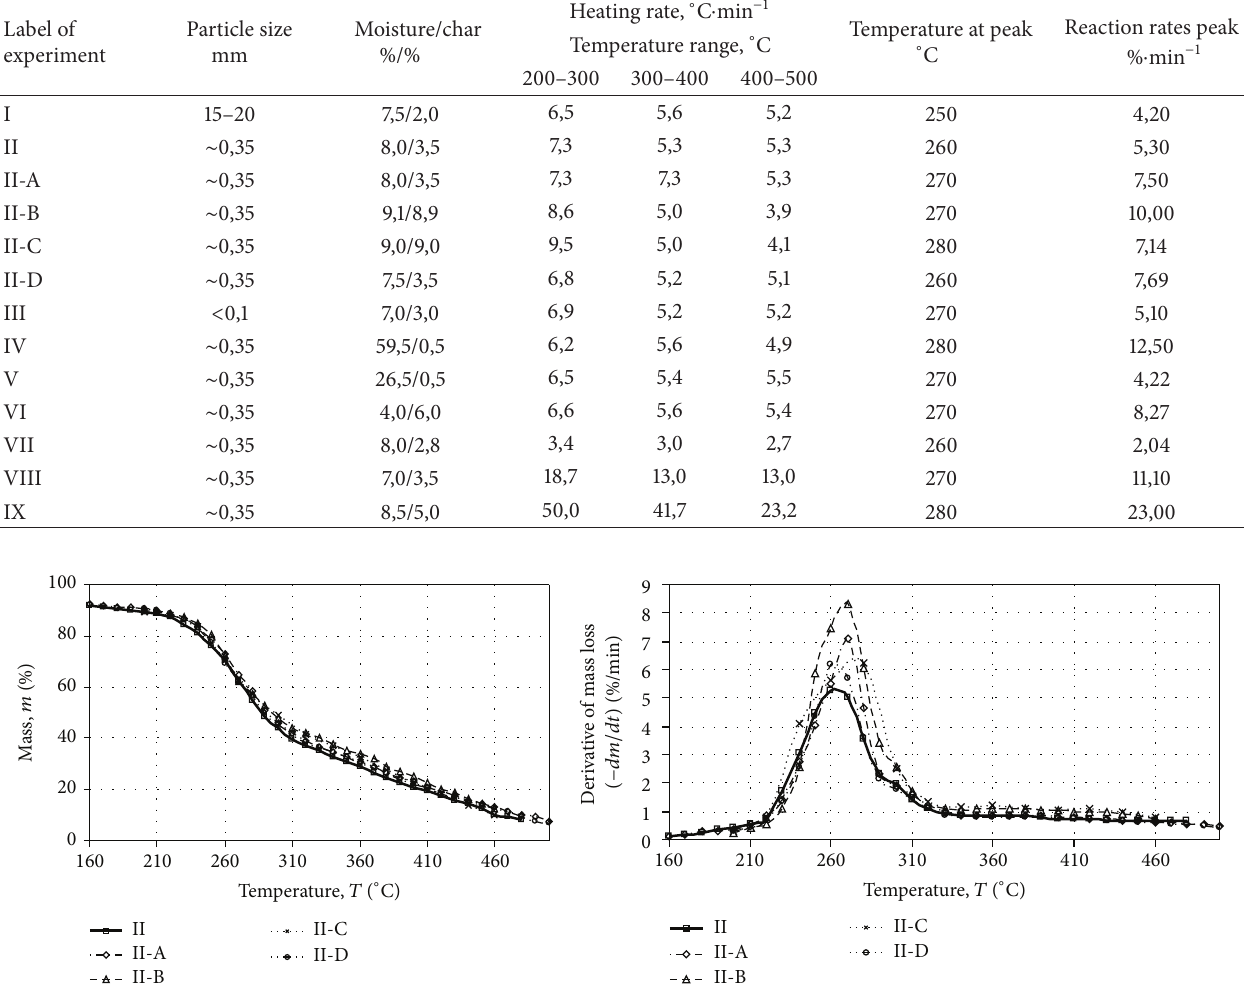
Table 4: Realized main parameters of the experiments.